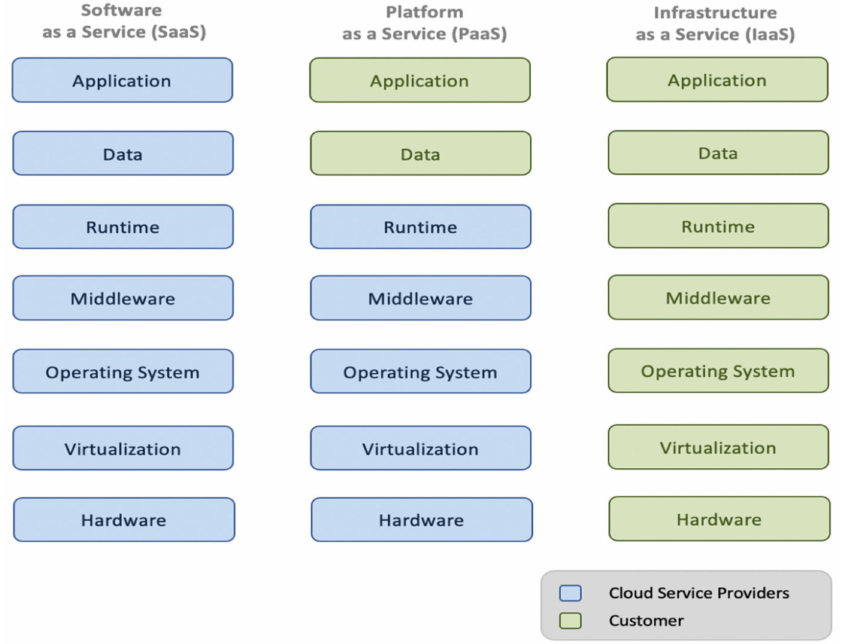
Figure 5. Cloud computing services delivery models’